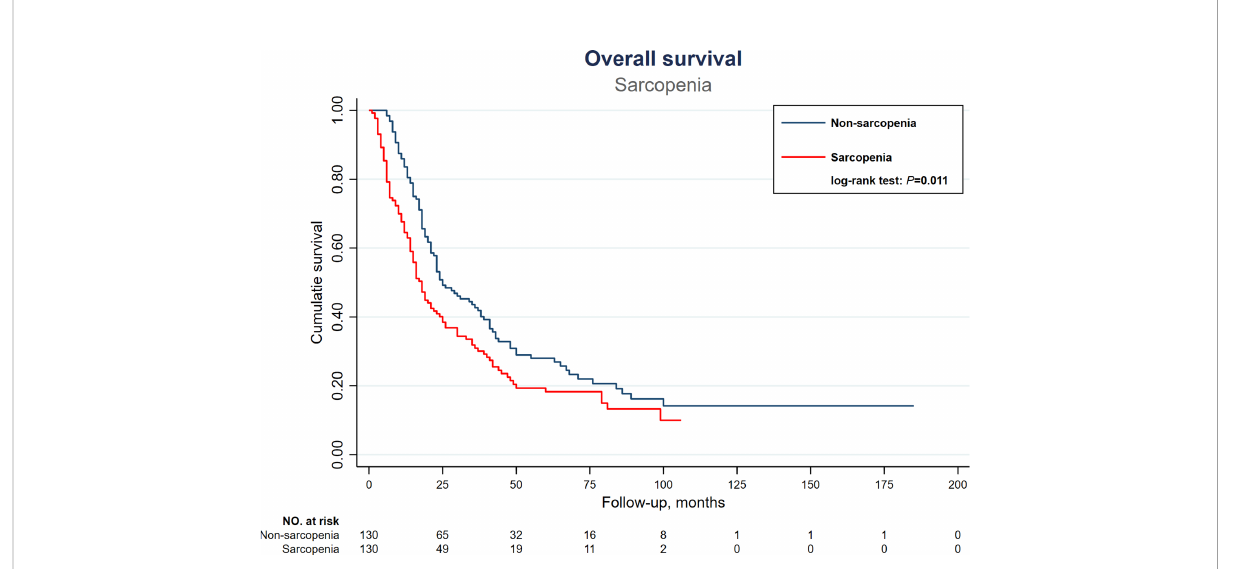
FIGURE 2 Kaplan-Meier overall survival curves of HCC patients receiving TACE therapy, strati fi ed by sarcopenia. HCC, hepatocellular carcinoma; TACE, transarterial